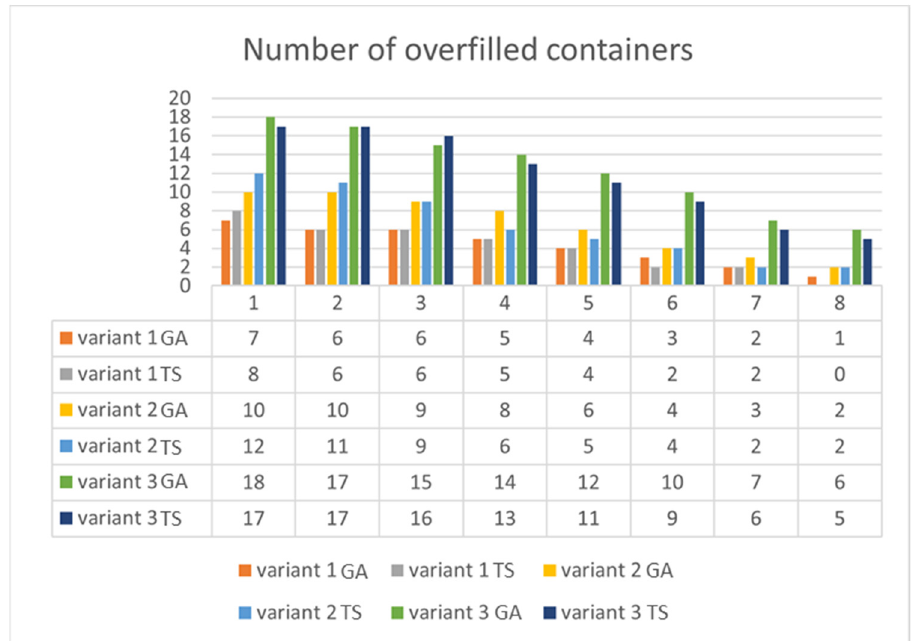
Figure 9. Simulation results of number of overfilled containers for various difficulty levels (each variant using both algorithms).